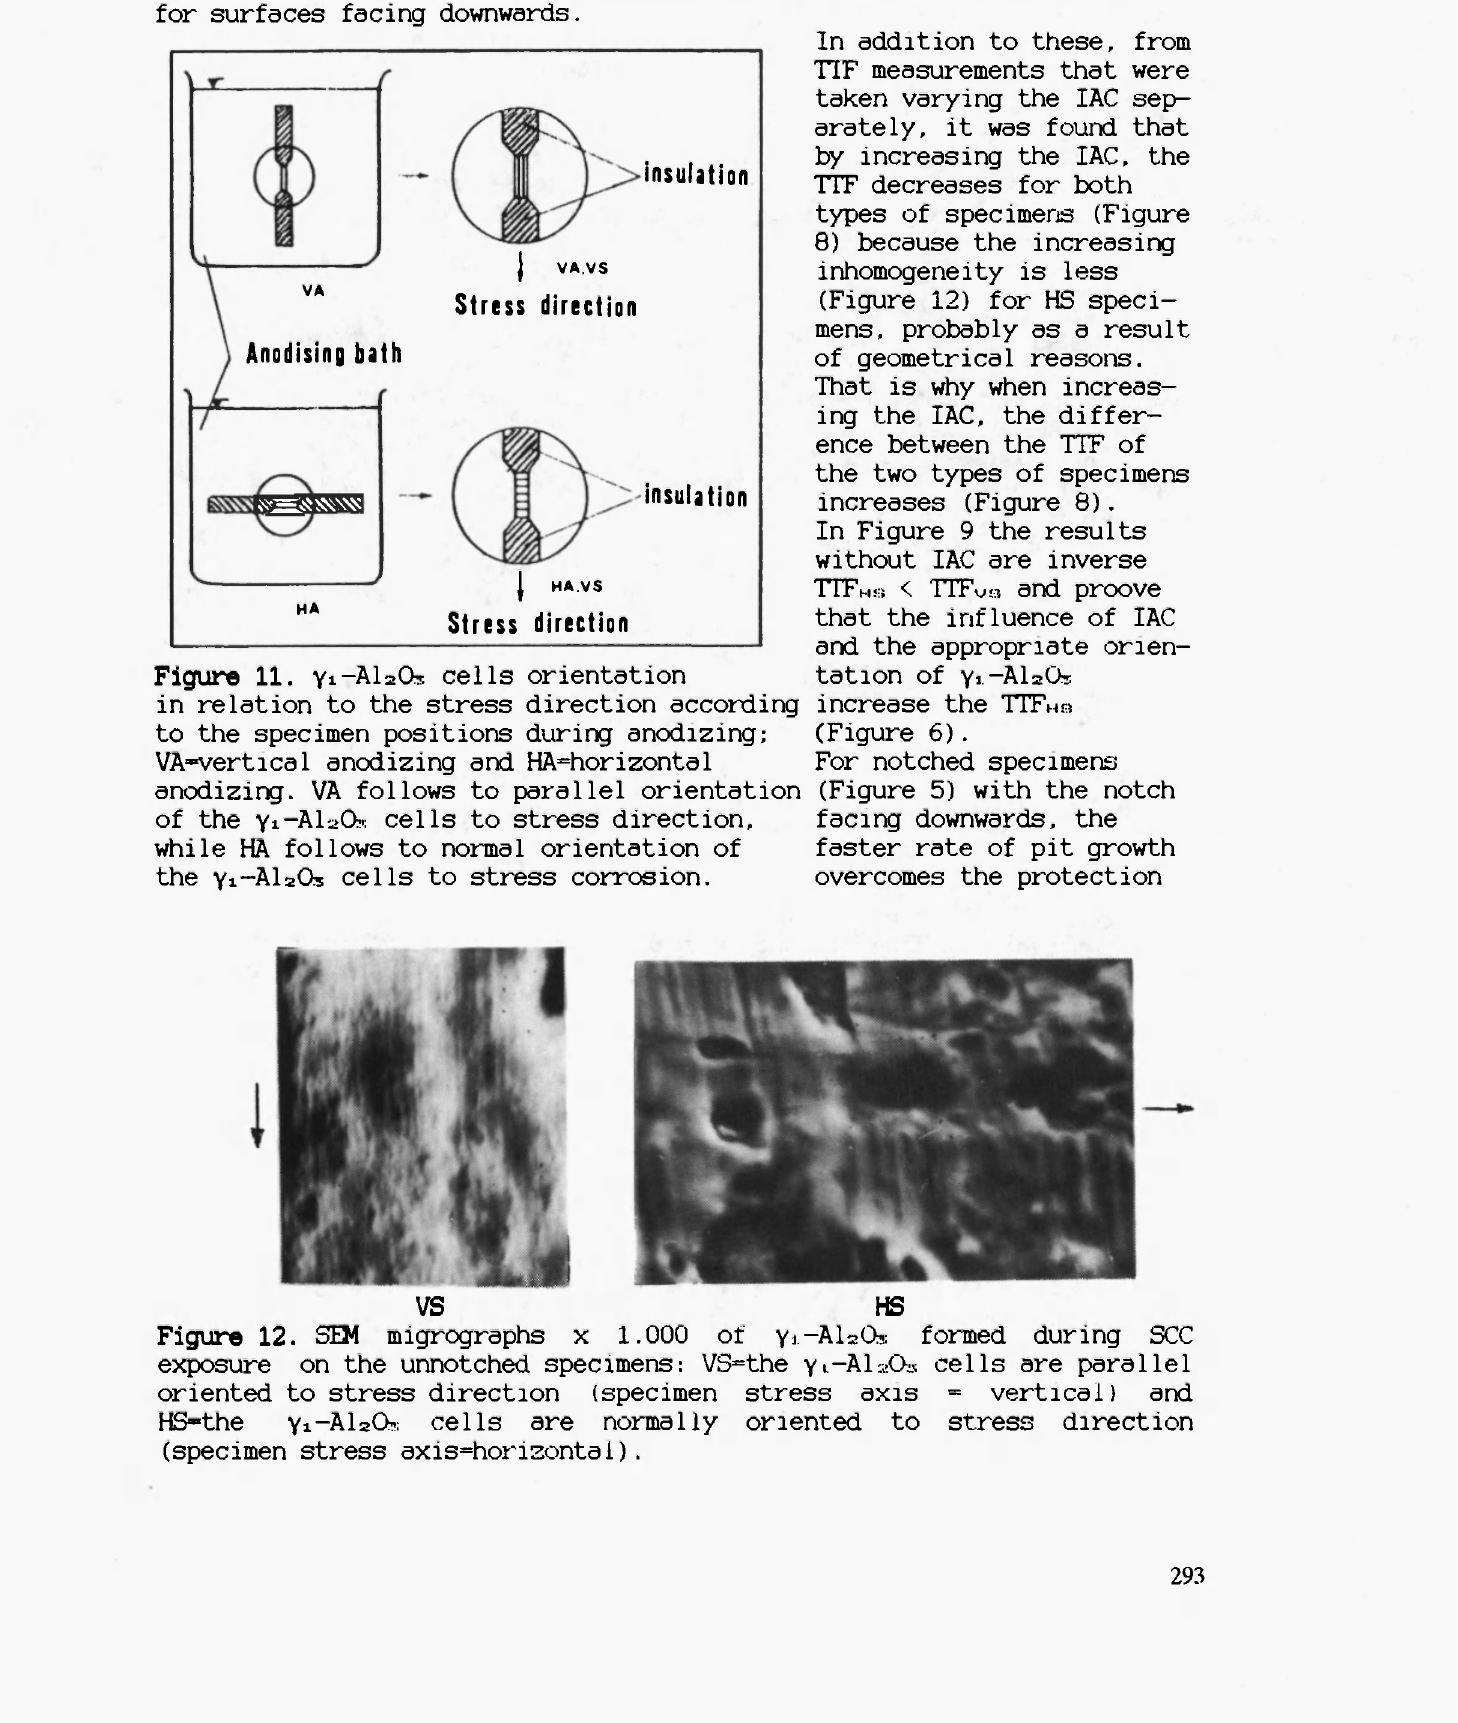
Figure 11. Yi-AlaOr. cells orientation